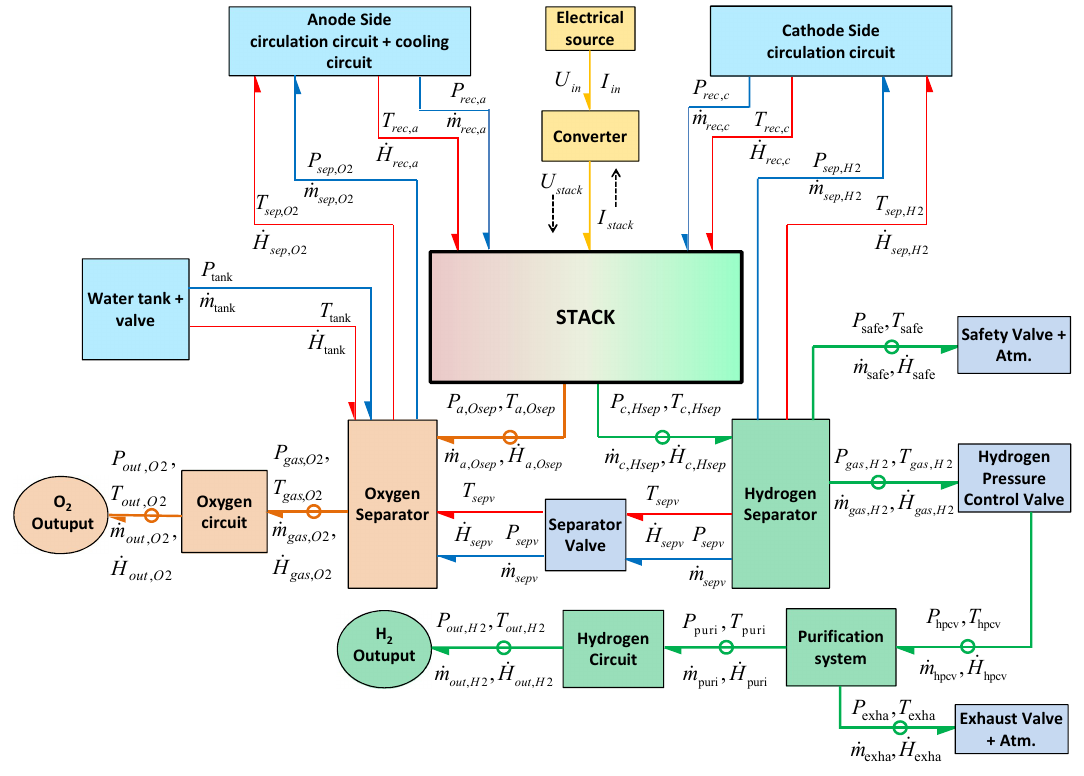
Figure 8. The word BG model of the electrolysis